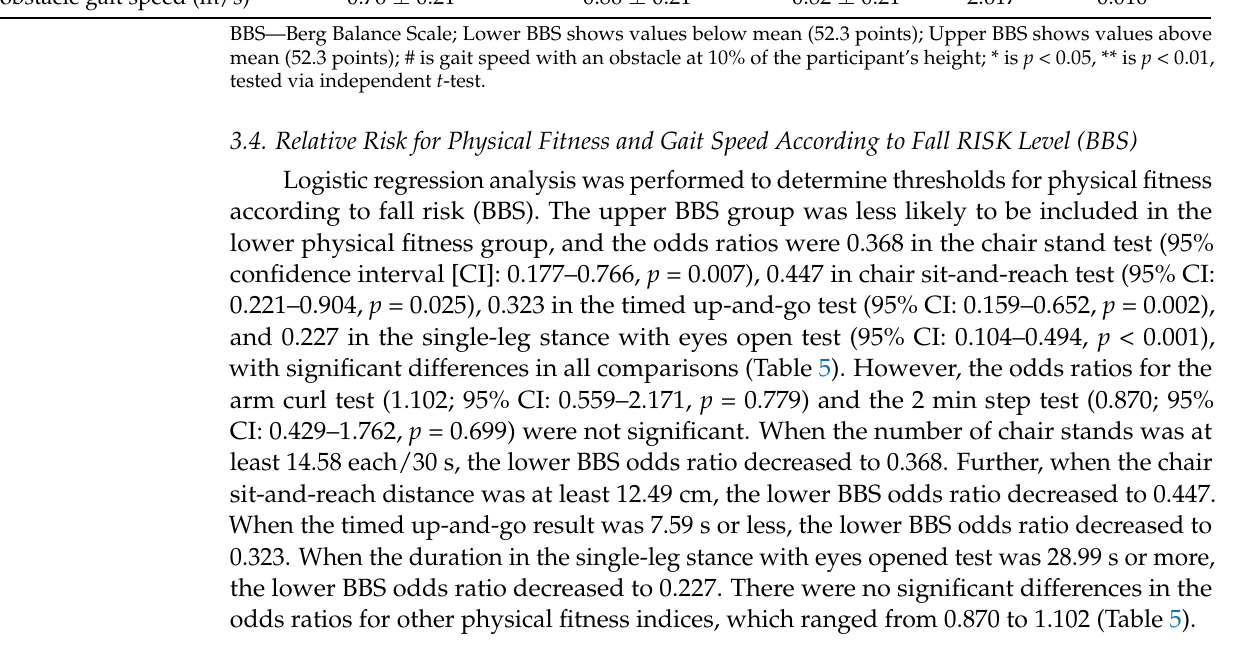
Table 5. The relative risk for different levels of physical fitness, according to fall risk levels